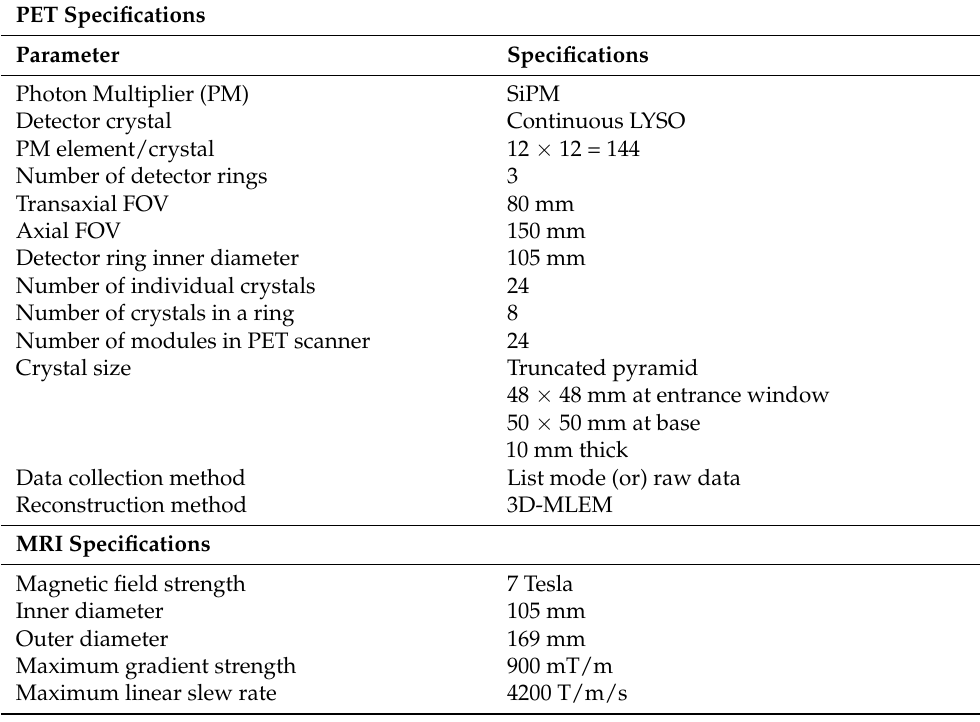
Table 1. Technical specifications of Bruker’s preclinical PET/MRI